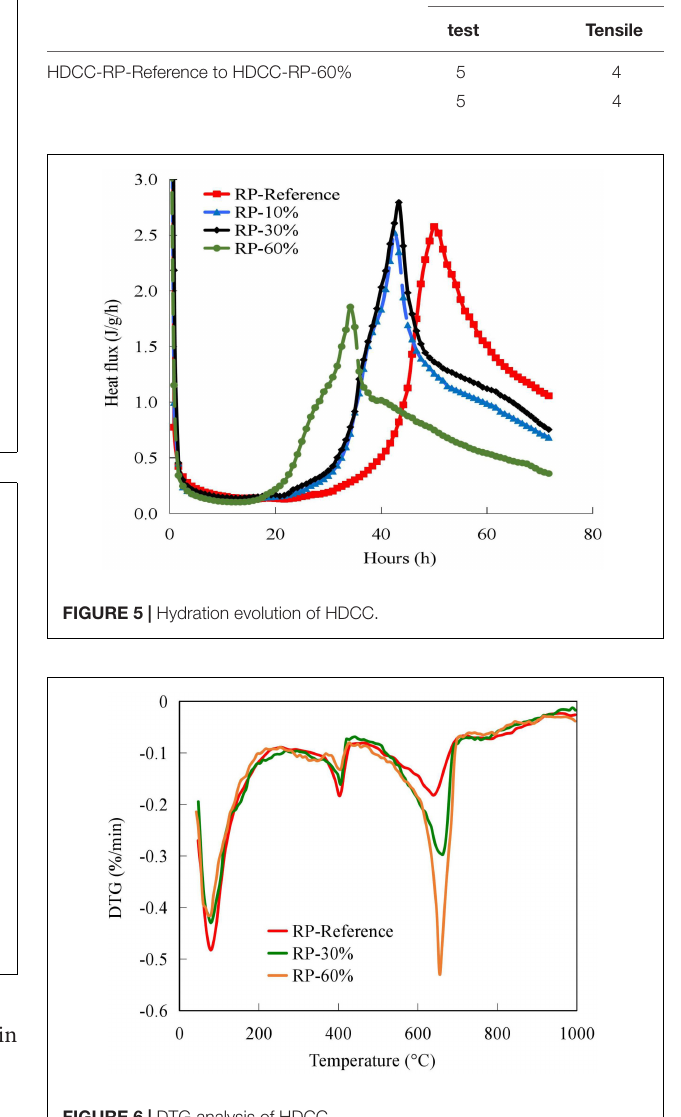
FIGURE 6 | DTG analysis of